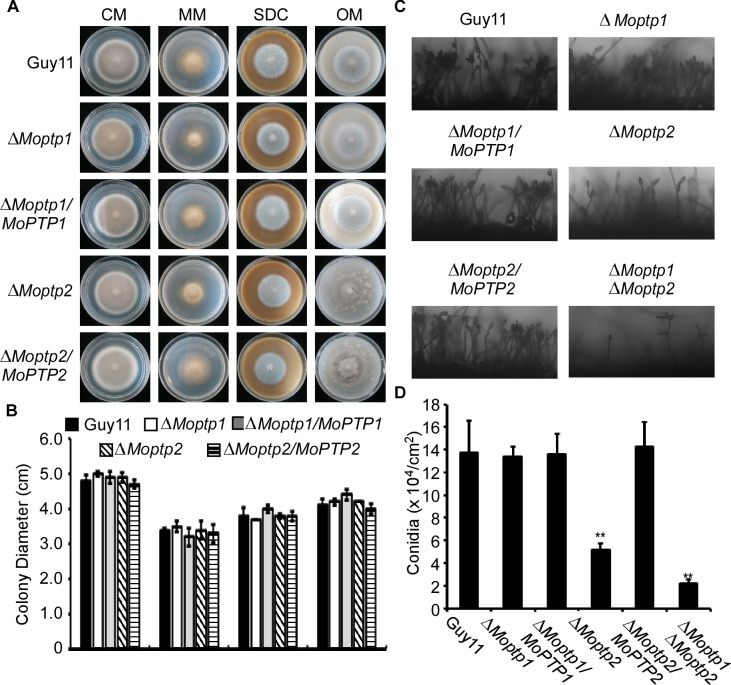
MoPtps are not involved in mycelial growth and conidiation.(A) Comparison of ∆Moptps and wild-type strain in colony morphology. Wild type, the ∆Moptps mutant and complementation strains were cultured at 28°C in darkness for 7 days. (B) Statistical analyses of the diameter of hypha of wild-type Guy11, the ∆Moptps mutant, and the complemented strain on different medium. Error bars represent the standard deviations and asterisks denote statistical significances (p<0.01) (C) Conidia development of the wild type, ∆Moptp1, ∆Moptp2, and the complement strains on SDC medium for 7 days were examined by light microscopy. (D) Statistical analysis of conidia production. Conidia produced by the wild-type, the mutants, and complemented strains on SDC medium for 10 days were collected, counted, and analyzed. ± SD is calculated from three repeated experiments and asterisks indicate statistically significant differences (Duncan's new multiple range test, p<0.01).